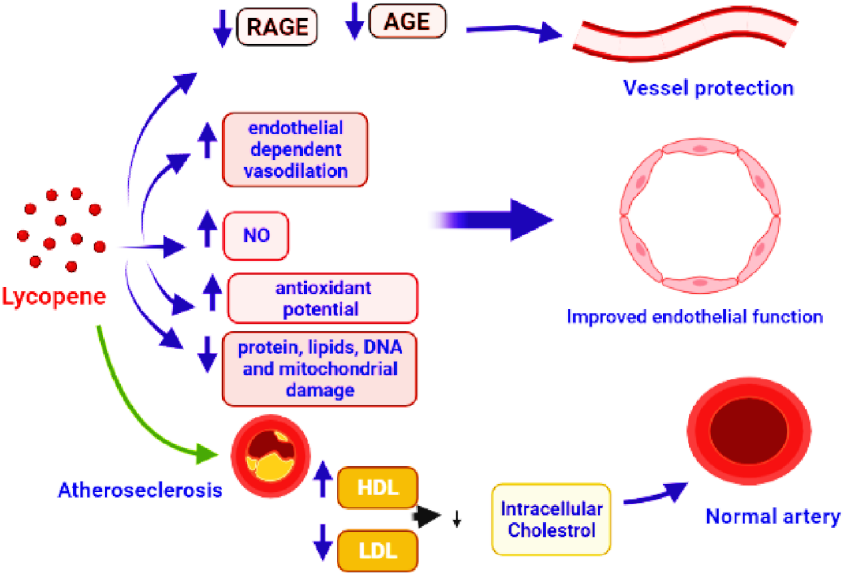
Figure 5. Demonstration of vessel protection by the application of lycopene that caused the inhibition of AGE and RAGE production. It also leads to vasodilation, protection of proteins, DNA, lipids, and mitochondrial damage, by boosting the antioxidant activity. Improved endothelial function is reached by increasing nitric oxide (NO) bioavailability, ensuring positive changes in the lipid profile and healthy arteries, and preventing